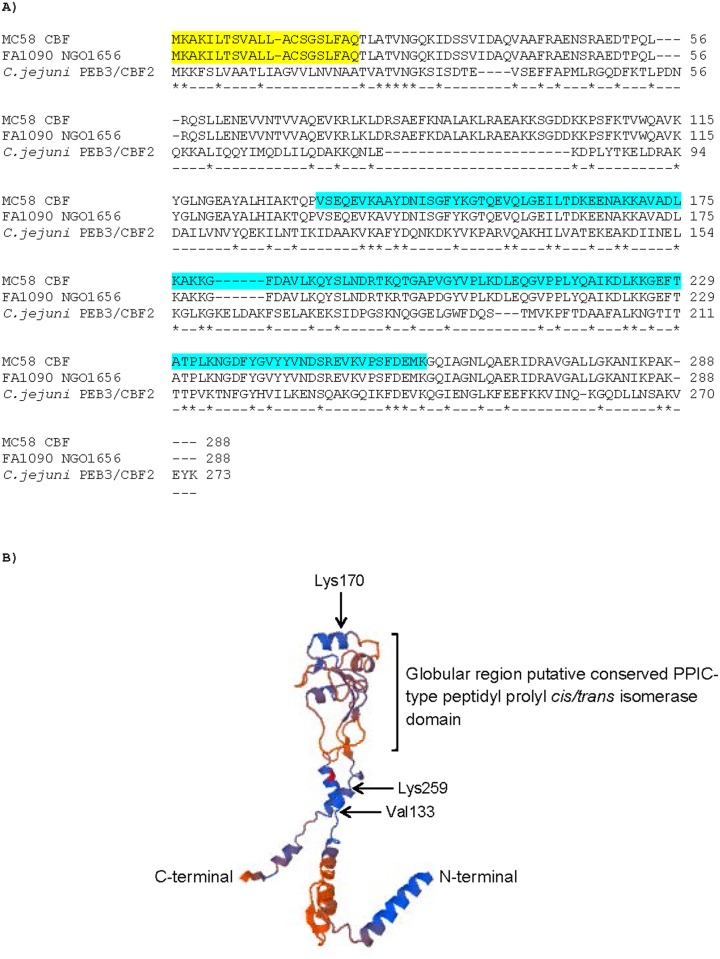
A. Amino acid sequence alignment of NMB0345 (NEIS1825, Cell Binding Factor, CBF) from N. meningitidis MC58, N.gonorrhoeae FA1090 and the Campylobacter jejuni PEB3/CBF2 protein. * denotes identical amino acids between all three proteins. Yellow-shaded amino acid sequences denote the putative signal leader peptides. The blue-shaded amino acid sequence denotes the presence of a putative conserved PPIC-type peptidyl prolyl cis/trans isomerase domain (interval 133–259) belonging to the Rotamase_2 superfamily. B) Putative structure of meningococcal CBF based on C.jejuni CBF. The structure of meningococcal CBF was putatively modelled in SWISS-model, using as a template the crystallized structure of 3rfw.1.A protein (PEB4), which is the most closely related structure to C. jejuni PEB3/CBF2 that we have available in Protein Data Bank.